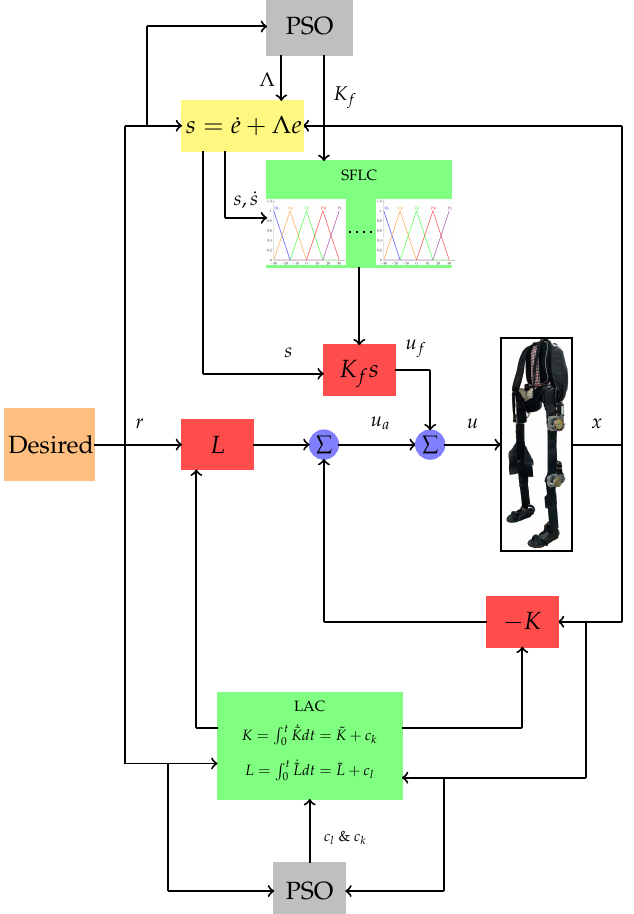
Figure 3. Overall block diagram of